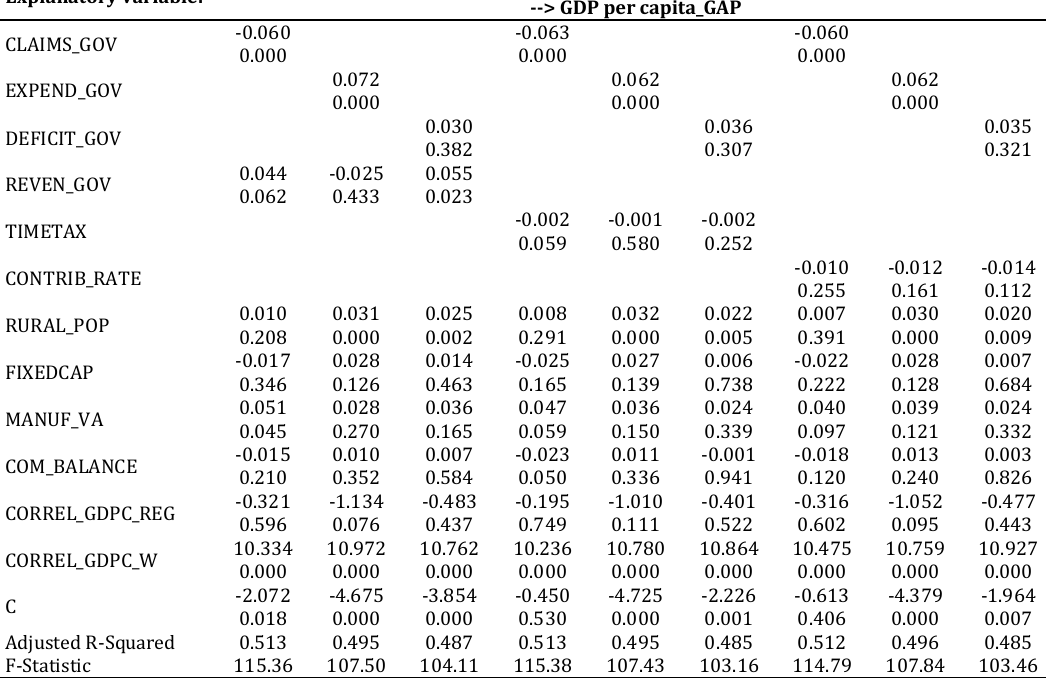
Table 3: Restricted model – Panel